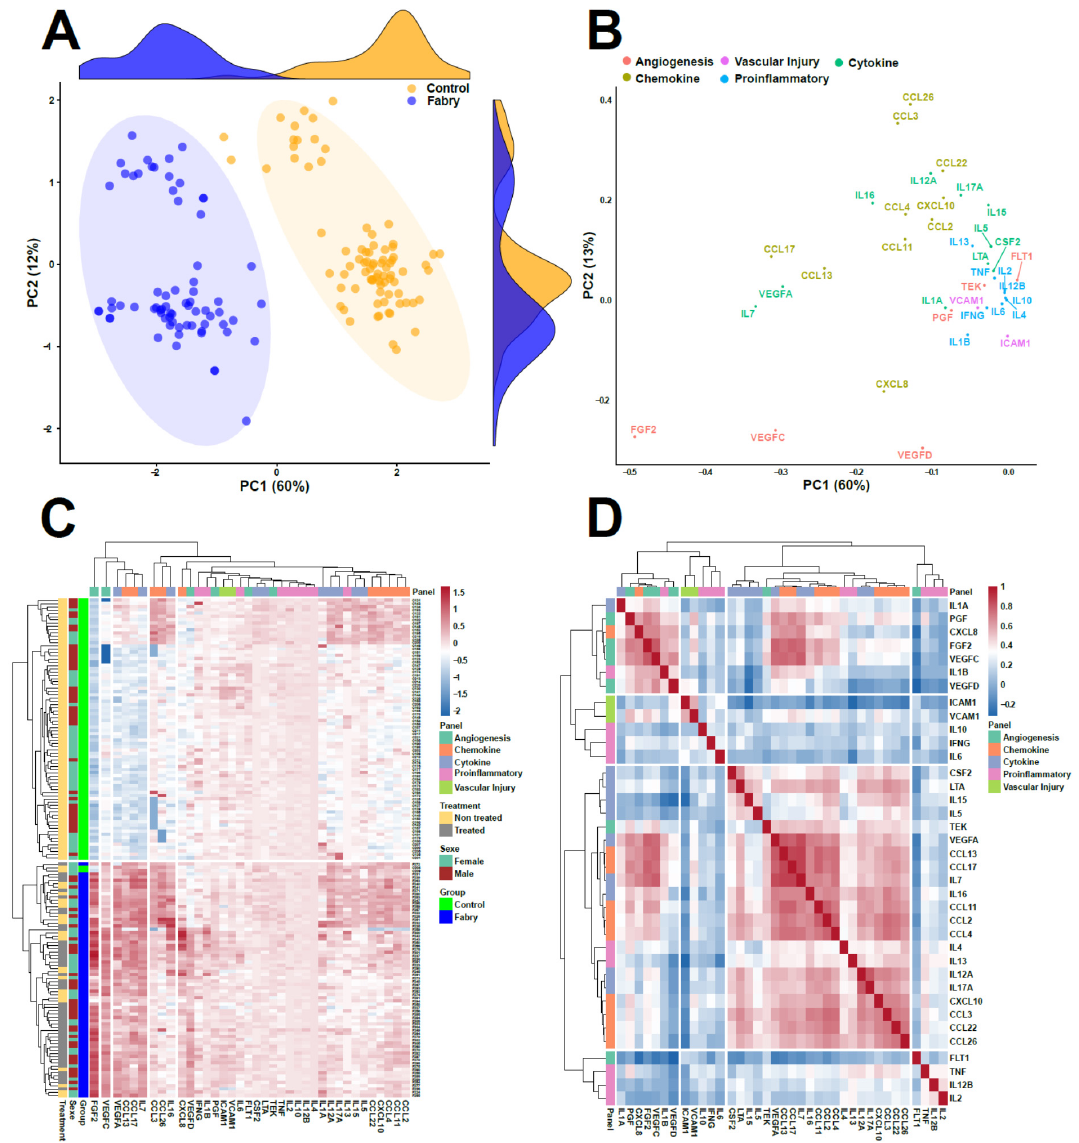
Figure 2. ( A ) Principal component analysis (PCA) score plot showing a clear separation between controls and Fabry samples. ( B ) PCA loadings showing the underlying proteins that drive this separation, mainly FGF2, IL-7, and VEGF. ( C ) Hierarchical cluster analysis of plasma samples based on protein levels. Classes are represented along the y -axis. The color code was used to represent log-scaled intensities of the proteins, showing the relative abundance of the protein according to the groups. The figure shows clear clustering. ( D ) Correlation heatmap between the assessed proteins and their hierarchical cluster analysis highlighting four main clusters. Low correlation is shown in blue and high correlation is shown in red.